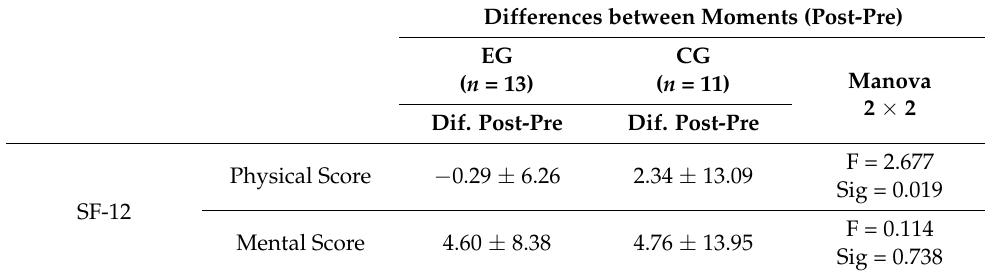
Table 5. Quality of life scores (intragroup and multivariant differences).